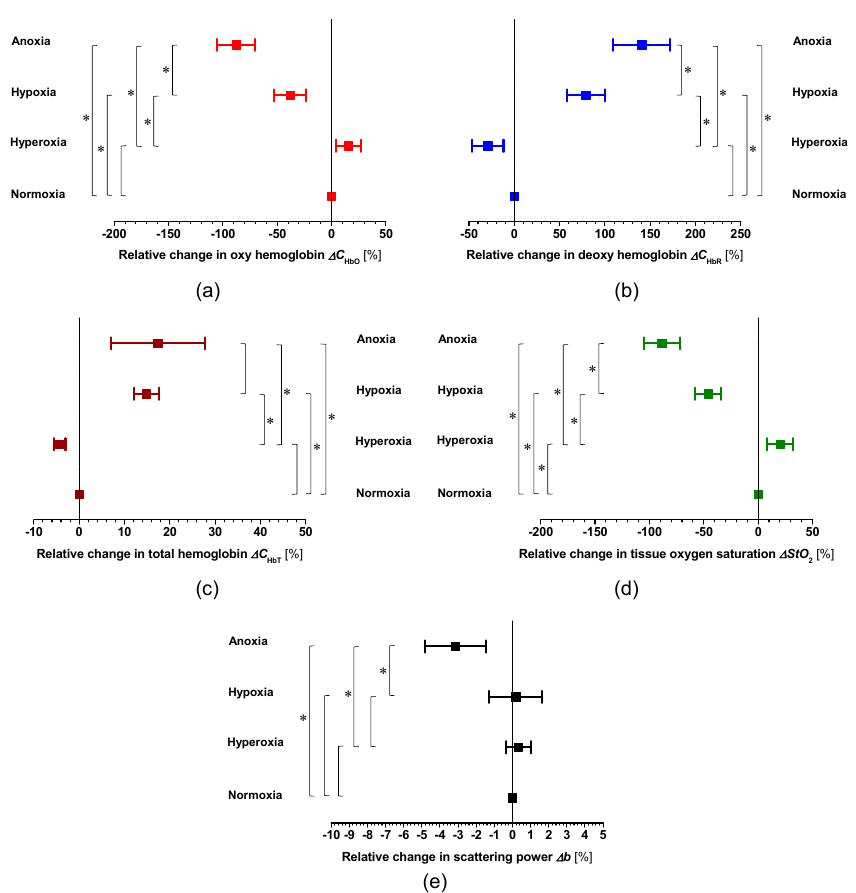
Figure 4. Relative change in ( a ) oxygenated hemoglobin ∆ C HbO , ( b ) deoxygenated hemoglobin ∆ C HbR , ( c ) total hemoglobin ∆ C HbT , ( d ) hemoglobin oxygen saturation ∆ StO 2 , and ( e ) scattering power b averaged over the ROIs for all six samples under conditions of hyperoxia, hypoxia, and anoxia. Error bars show standard deviations ( n = 6). * p < 0.01.